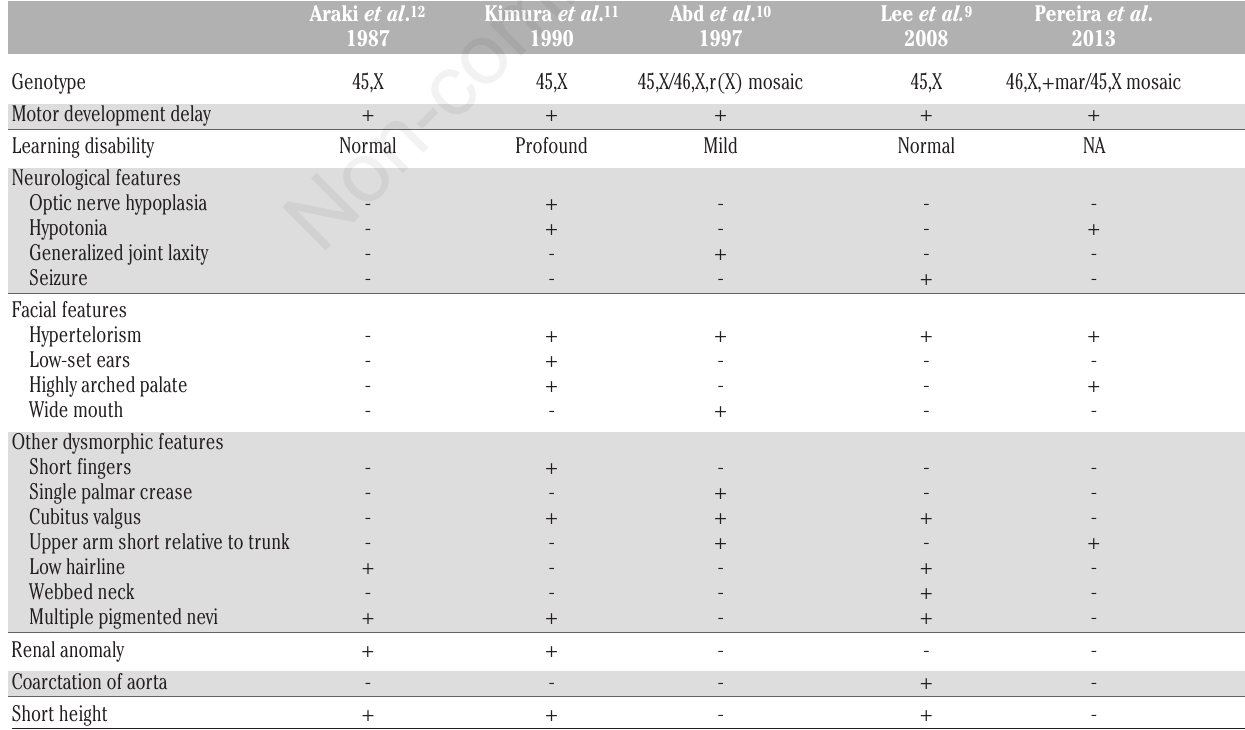
Table 1. Clinical features of 5 patients with Turner Syndrome and agenesis of the corpus callosum .